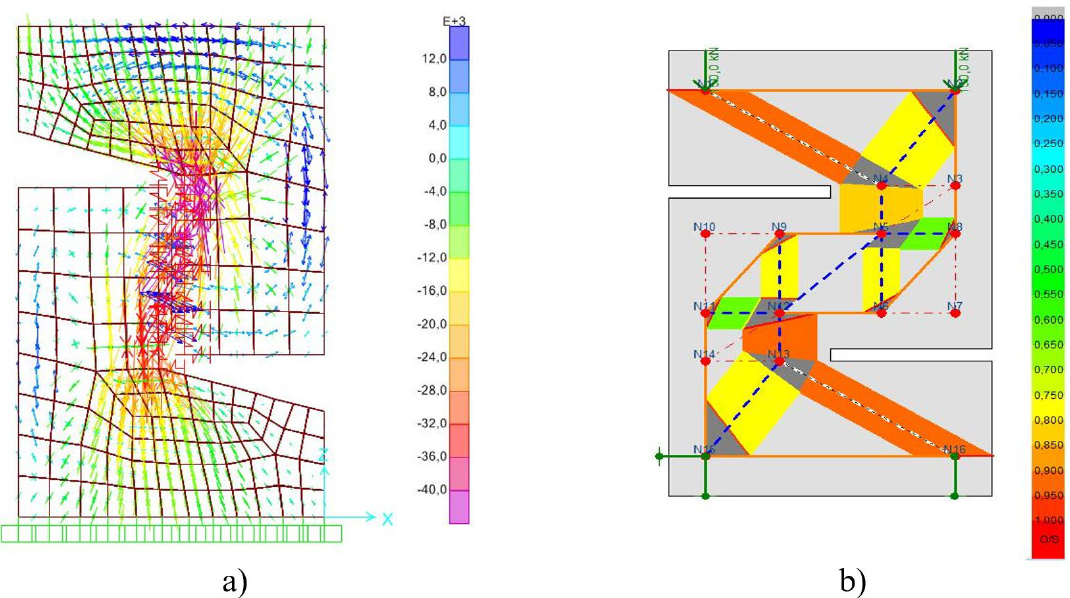
Figure 2. Push-off specimen stress analysis: a) main stress distribution using SAP software (2000) ® and b) strut and tie model using the software CAST ® [15].